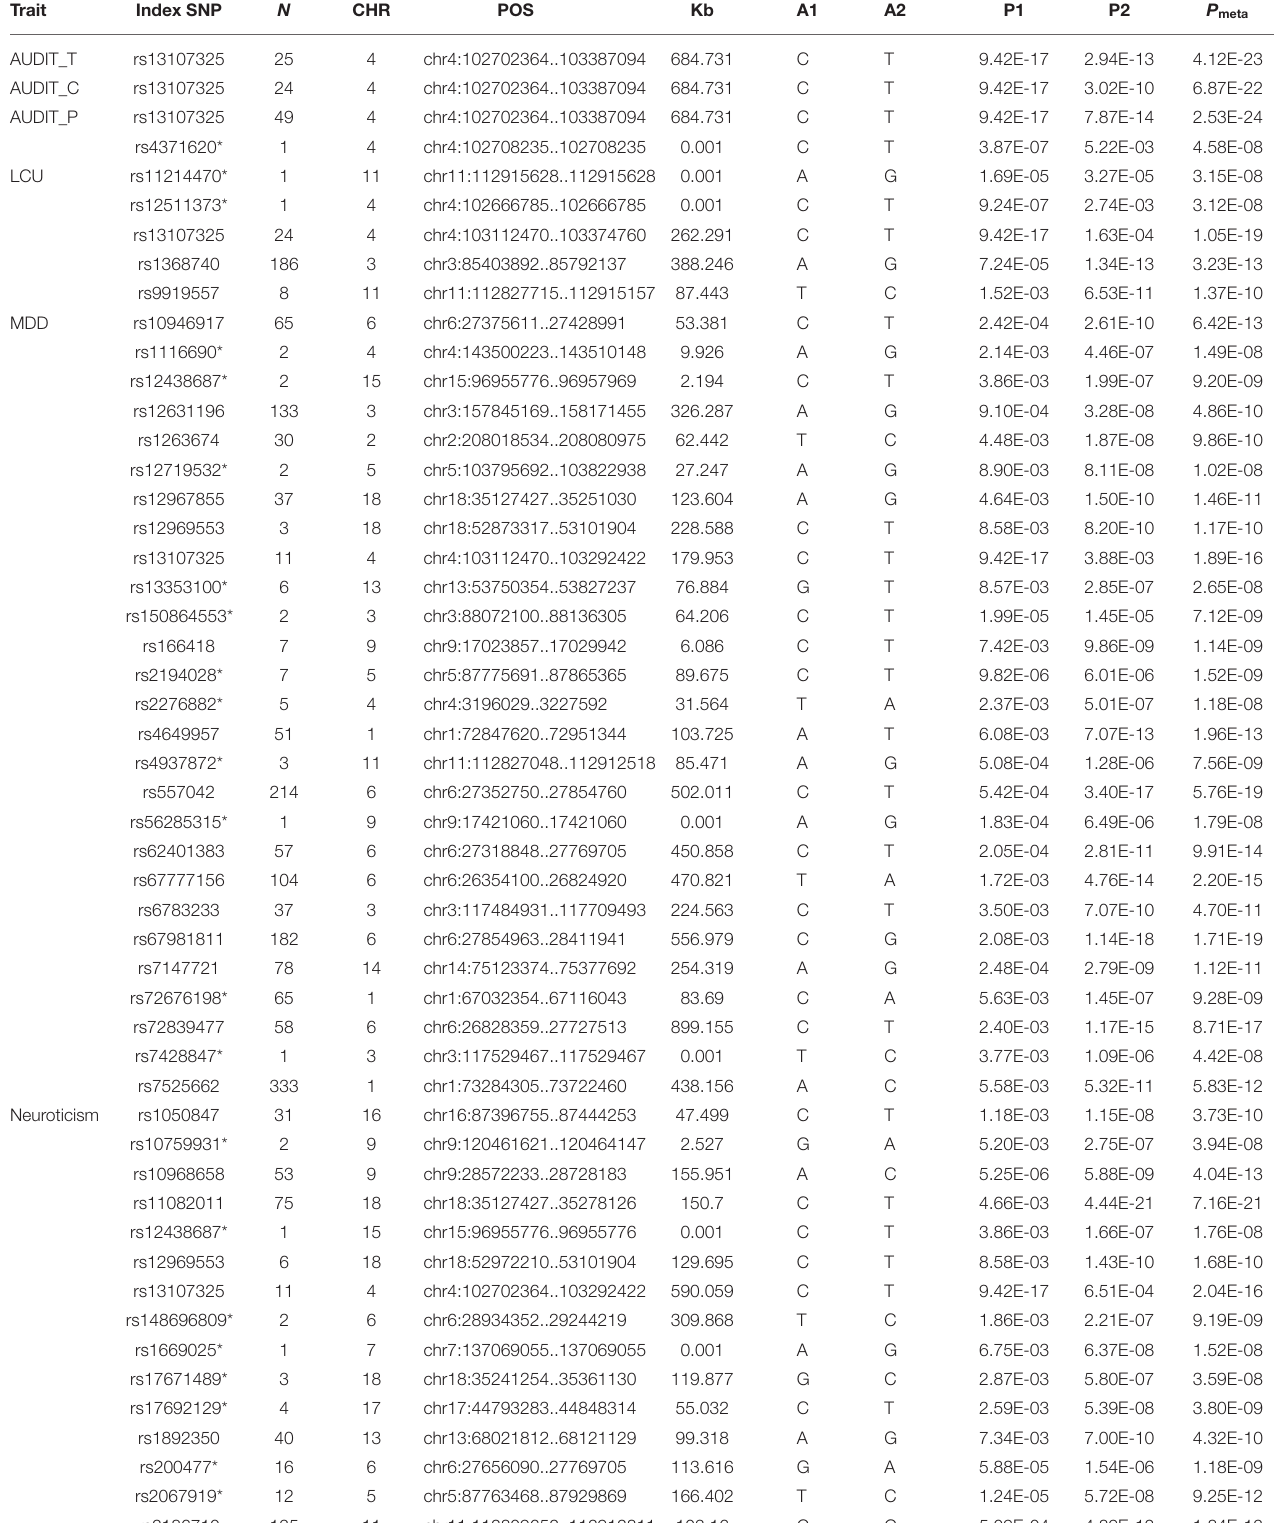
TABLE 2 | Summary of the 73 genomic loci associated with decaffeinated coffee consumption and neuropsychiatric traits in cross-trait meta-analysis.